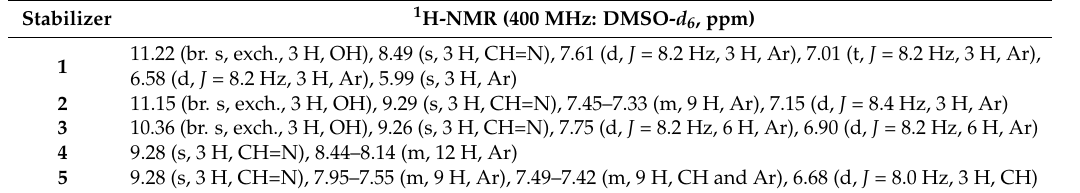
Table 3. 1 H-NMR spectral data for 1 – 5